Question: Which kind of chart has been used to present this data?
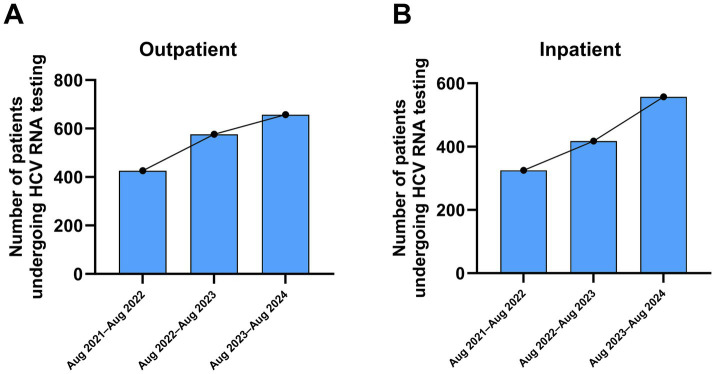
Answer: line